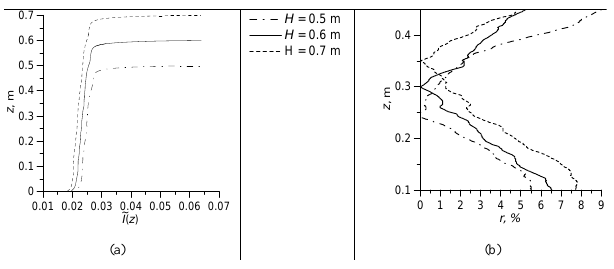
Fig. 13. Relative intensity ˜ I(z) in the direction (cid:127) ∗∗ (a) and the de- viation r(z) (b) on the vertical wall AB of the homogeneous snow- pack. The snow single scattering albedo ω snow D = 1m, and no black film, for different depths H